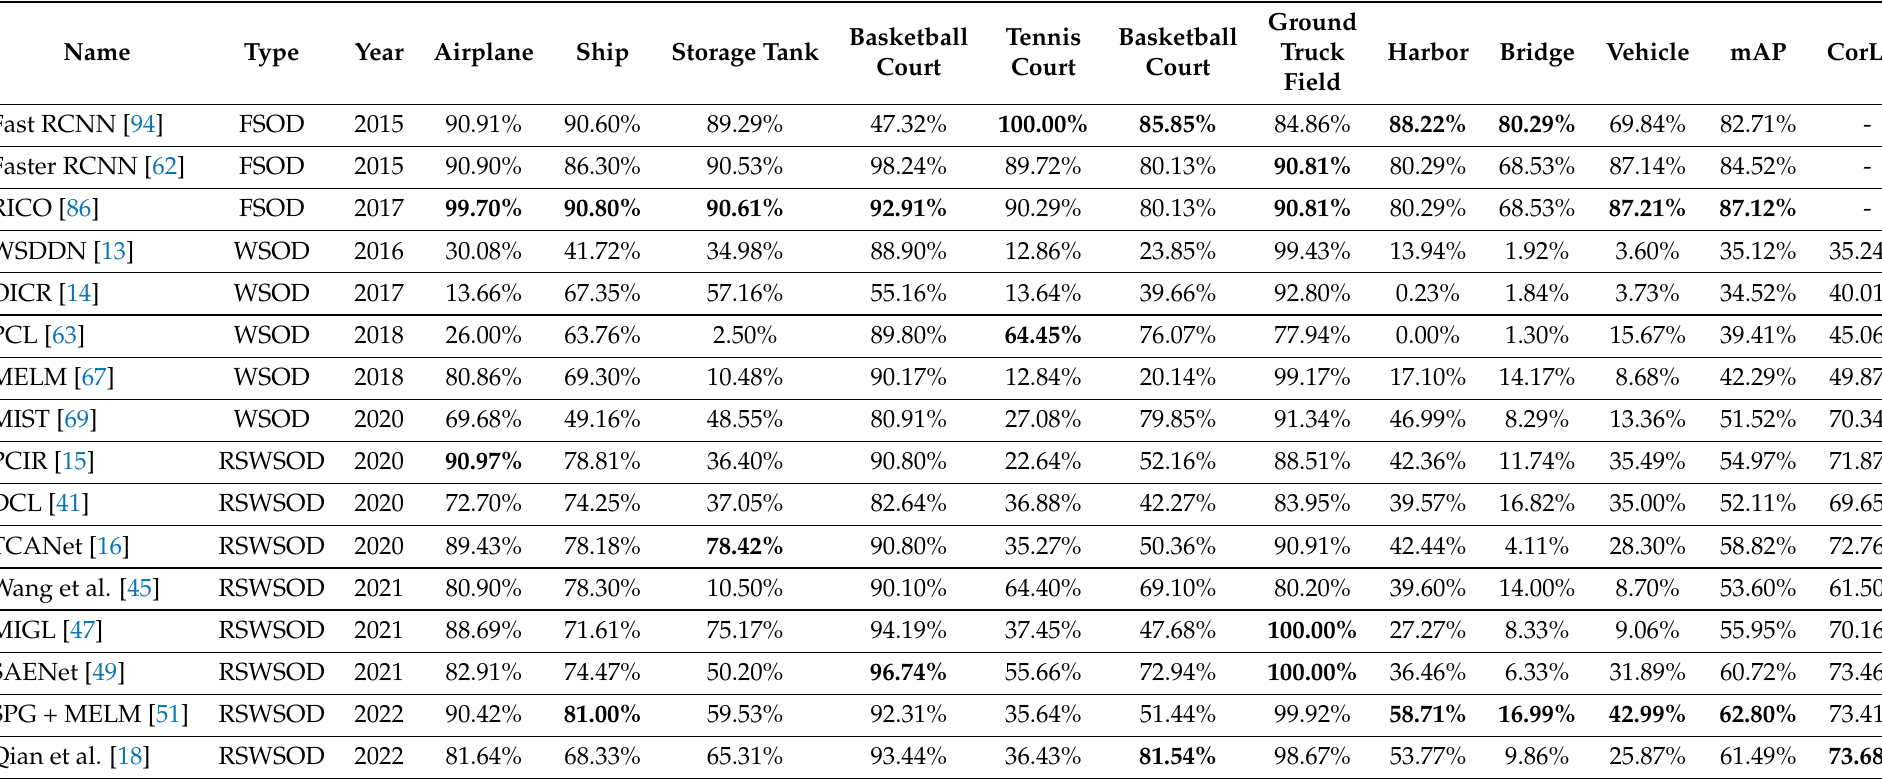
Table 6. Results of the methods on the NWPU VHR-10.v2 dataset. Three well-known fully supervised methods from the literature are reported for a fair comparison. The columns report the Average Precision (AP) for each category, the mean Average Precision (mAP), and the CorLoc for each method. The best-performing techniques for each class are indicated in